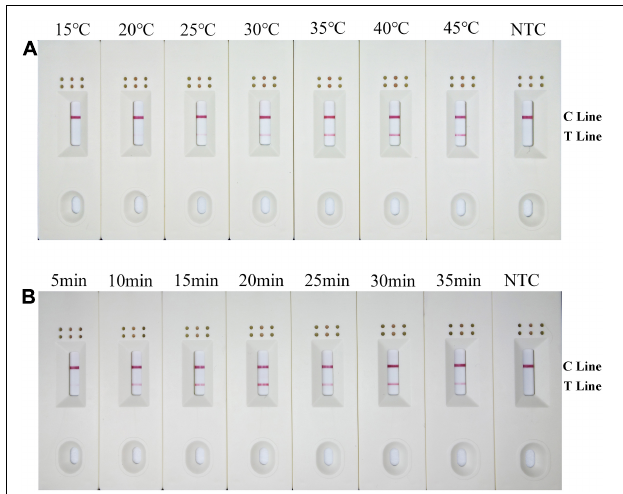
FIGURE 4 | Optimization of the modified primer–probe set in RPA–LFD assay. (A) Optimal reaction temperature of the RPA–LFD assay. The figure shows the LFD results of RPA amplification at different temperatures. The temperature is displayed at the top of each dipstick. The amplification template is B. xylophilus gDNA. The NTC band is no template control carried out at 38 ◦ C. The positions of the control and test lines are shown on the right side of the dipstick. (B) Optimal reaction time of the RPA–LFD assay. The image shows the LFD results of RPA amplifications with different times. The time to perform the RPA reaction is displayed at the top of each dipstick. The amplification template is B. xylophilus gDNA. NTC dipsticks are performed for 10 min without template. The positions of the control and test lines are shown on the right side of the